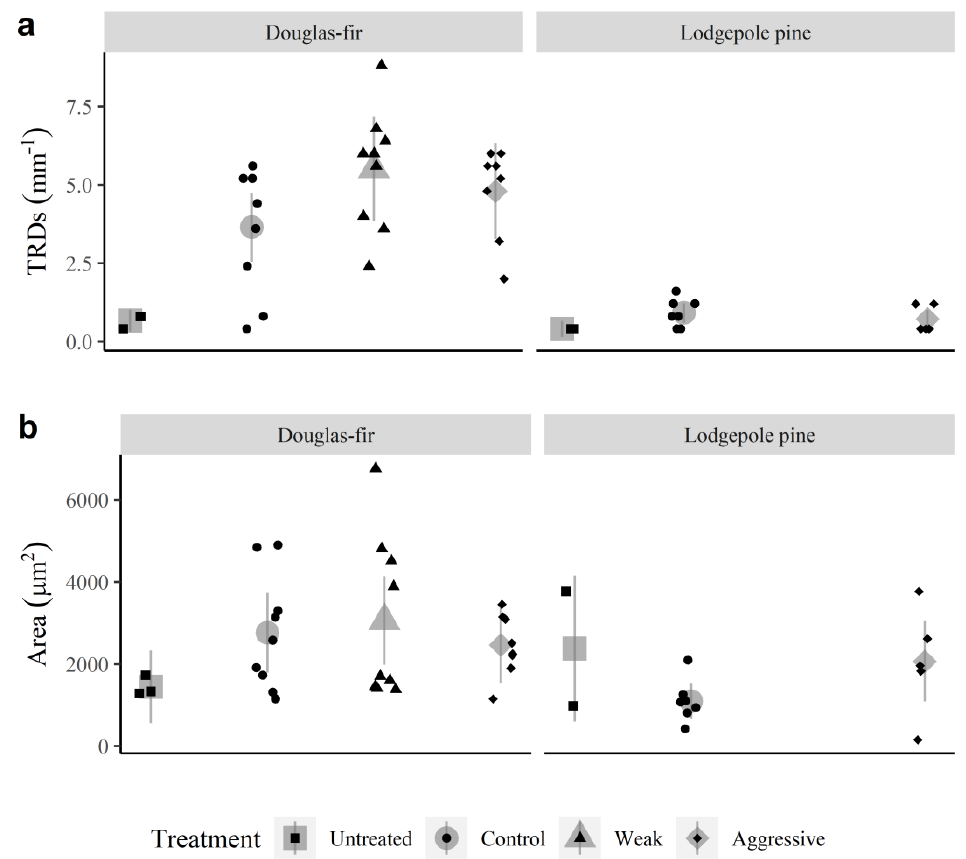
Figure 4. TRD density ( a ) and cross-sectional area ( b ) between species and their treatments. Observed points are shown in black and estimated means are shown in gray with corresponding 95% confidence intervals. Within Douglas-fir, TRD density was lower in the untreated trees relative to all treatments, whereas within lodgepole pine, only the Control treatment group was significantly higher than the untreated trees. No significant differences in TRD area were found within species, but within the Control treatment, Douglas-fir trees had significantly larger TRDs than lodgepole pine resin ducts.